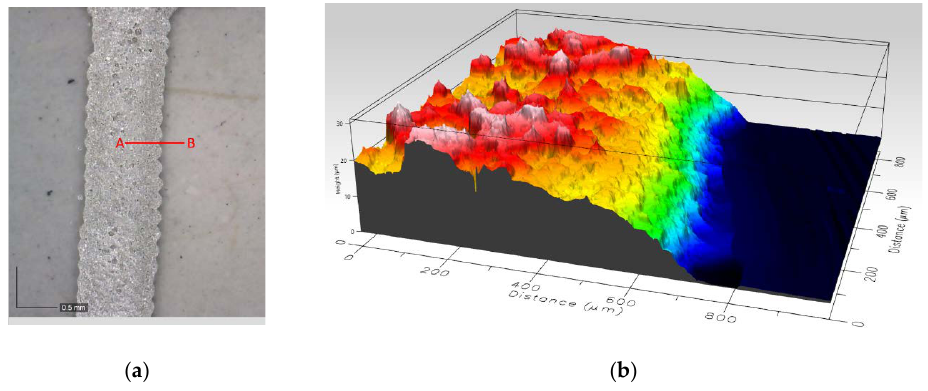
Figure 2. ( a ) Magnification view of a track of electrode; ( b ) Right: thickness of view A–B; average thickness